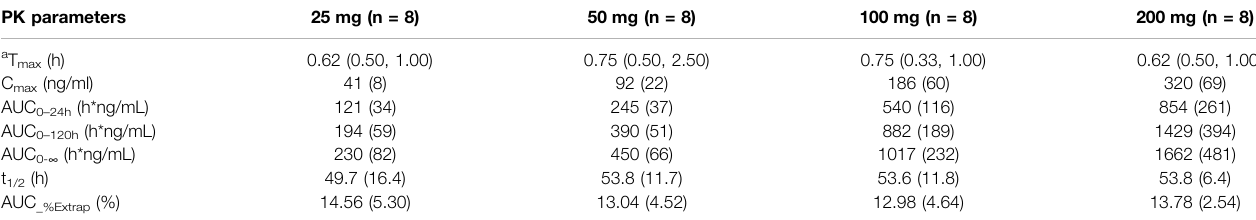
TABLE 2 | Pharmacokinetic parameters of tenofovir of the single-dose in each treatment group in the fasted state (mean ± SD). PK parameters